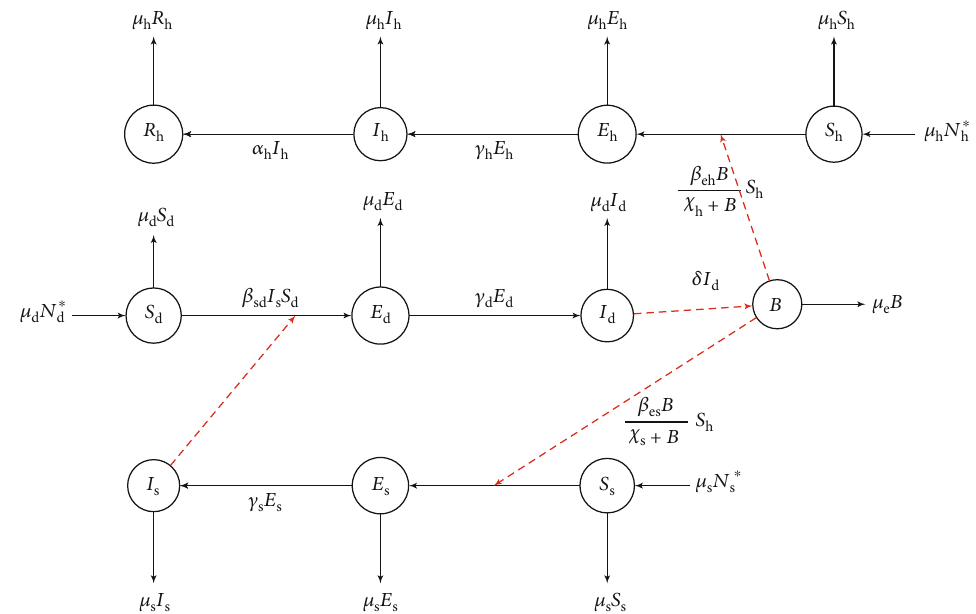
Figure 1: The fl ow diagram for cystic echinococcosis transmission